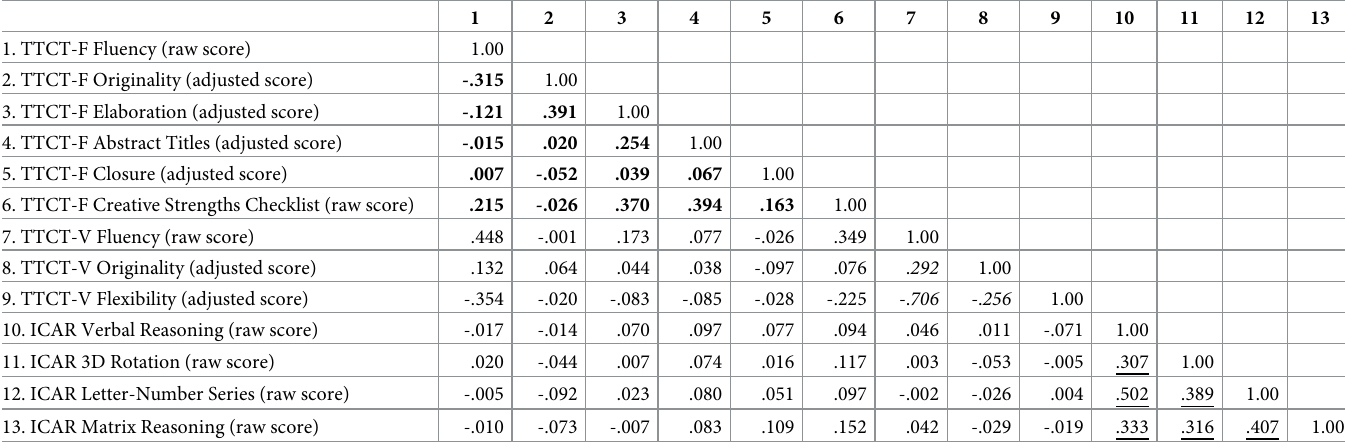
Table 3. Correlation table for variables used in the CFA